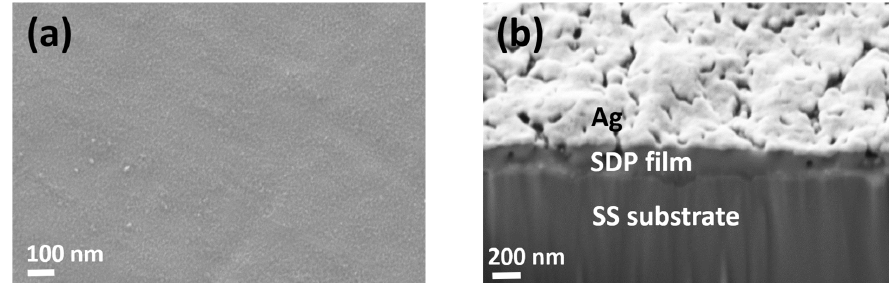
Figure 6. Microstructural characterization of the previous pyrolyzed ink ‐ jetted SDP ‐ Y 2 O 3 film. ( a ) SEM micrograph where no pores neither cracks are present; ( b ) FIB cross sectional image which allows confirming the coverage of the defects of the raw metallic substrate underneath.